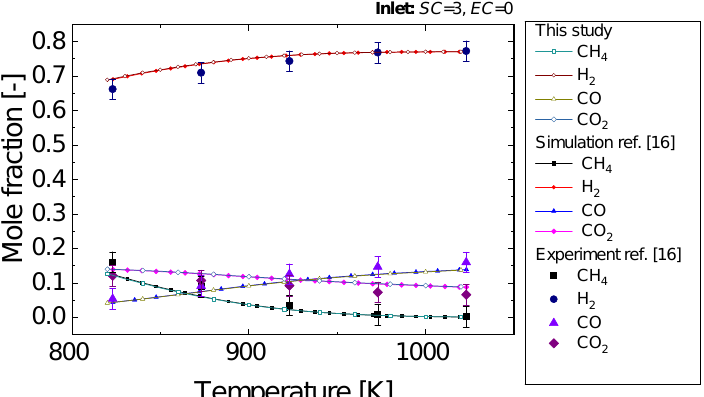
Figure 2. Equilibrium calculation using Parametric Equation Formalism versus experimental data from the ref. [16].